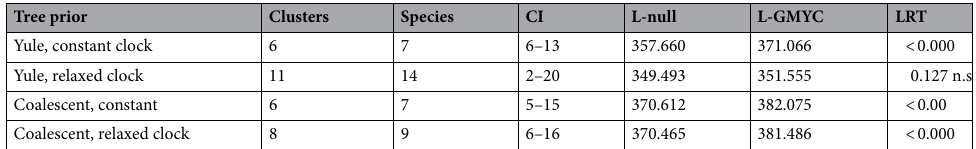
Table 2. Results of generalised mixed yule coalescent (GMYC) analyses of COI data. Clusters, OTUs identifed by GMYC containing more than one specimen; Species, number of ML entities (includes singletons); CI, confidence interval for number of entities; L-Null, likelihood of the null model (i.e. all sequences form a single cluster); L-GMYC, likelihood of GMYC model; LRT, P -value of likelihood ratio